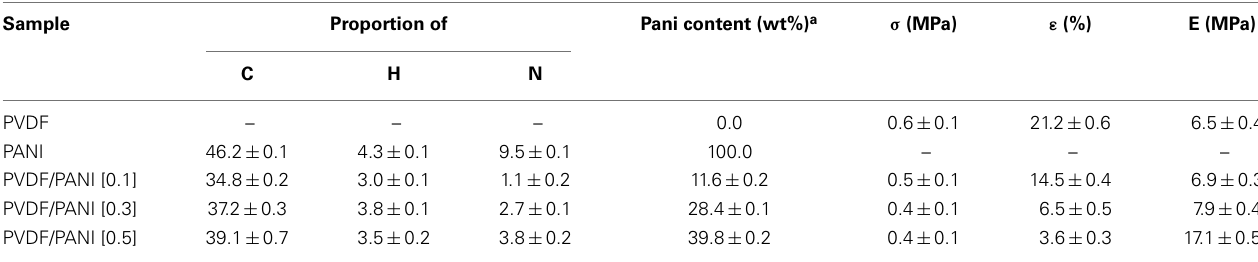
Table 1 | Elemental analysis, PANI content, and tensile properties of electrospun PVDF, PVDF/PANI mats